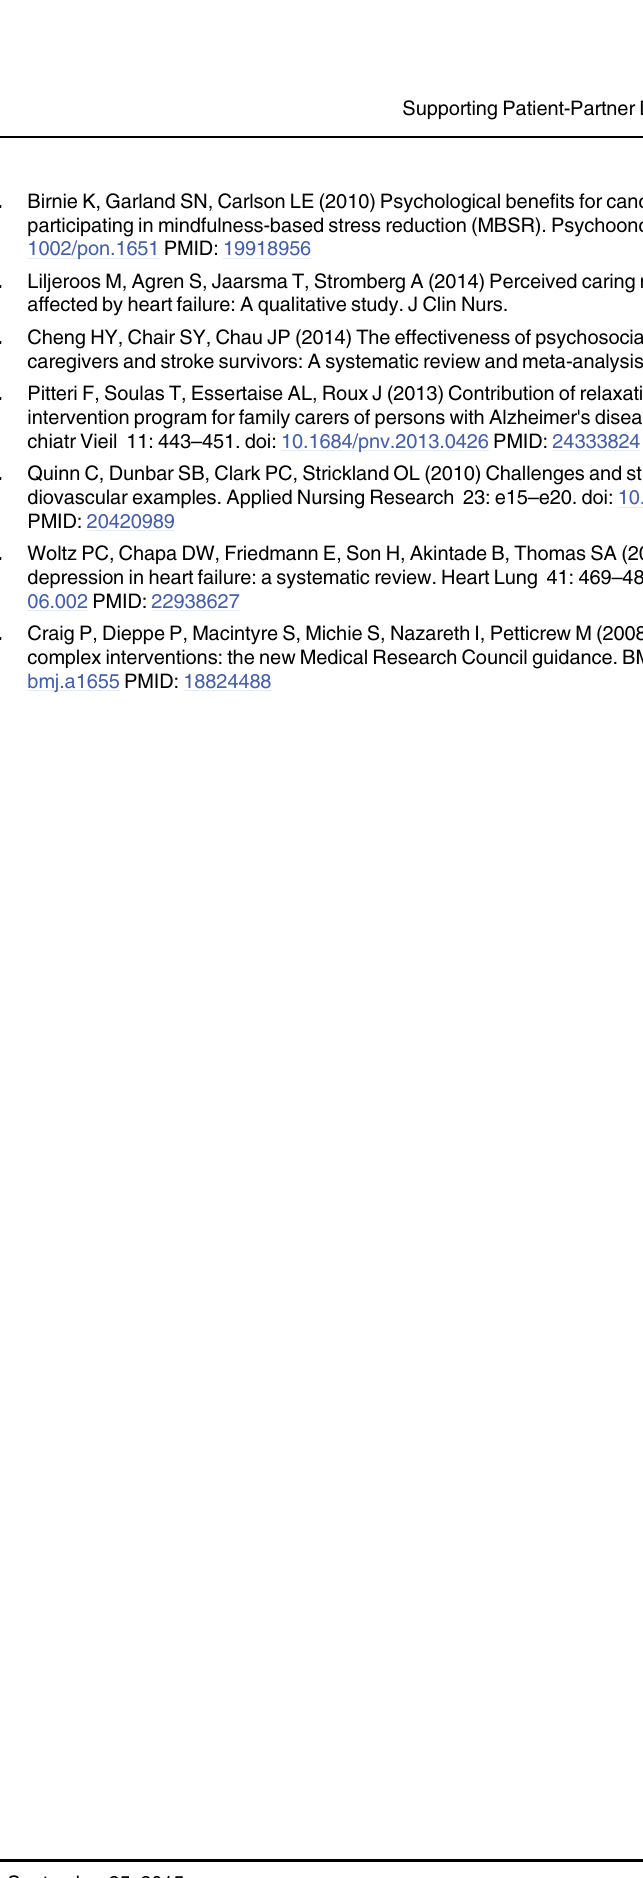
PLOS ONE | DOI:10.1371/journal.pone.0138058 September 25,